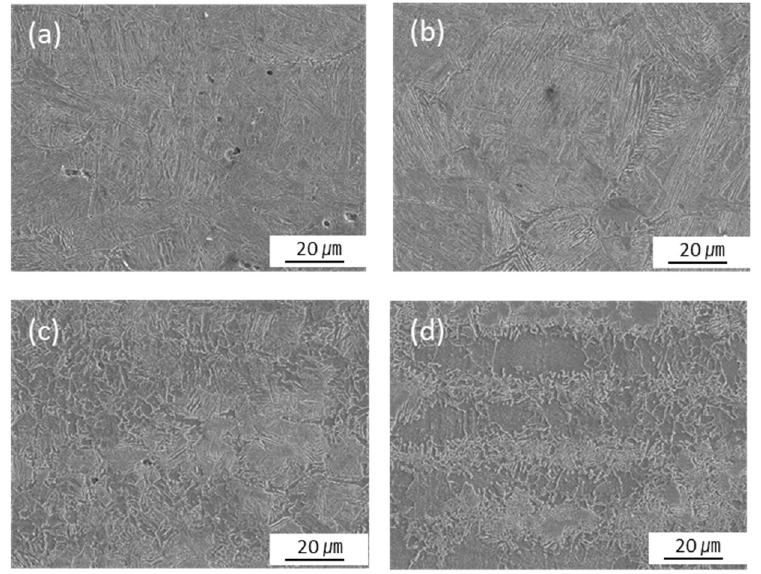
Figure 14. SEM image of microstructure in the welded joint: ( a ) point1, ( b ) point2, ( c ) point3 and ( d ) point4.